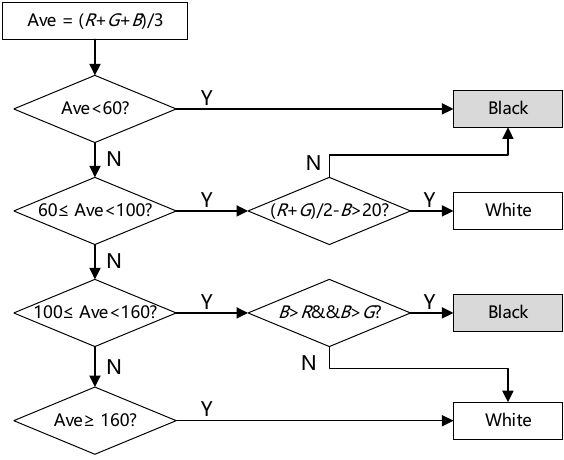
Figure 3. Binarization method based on color